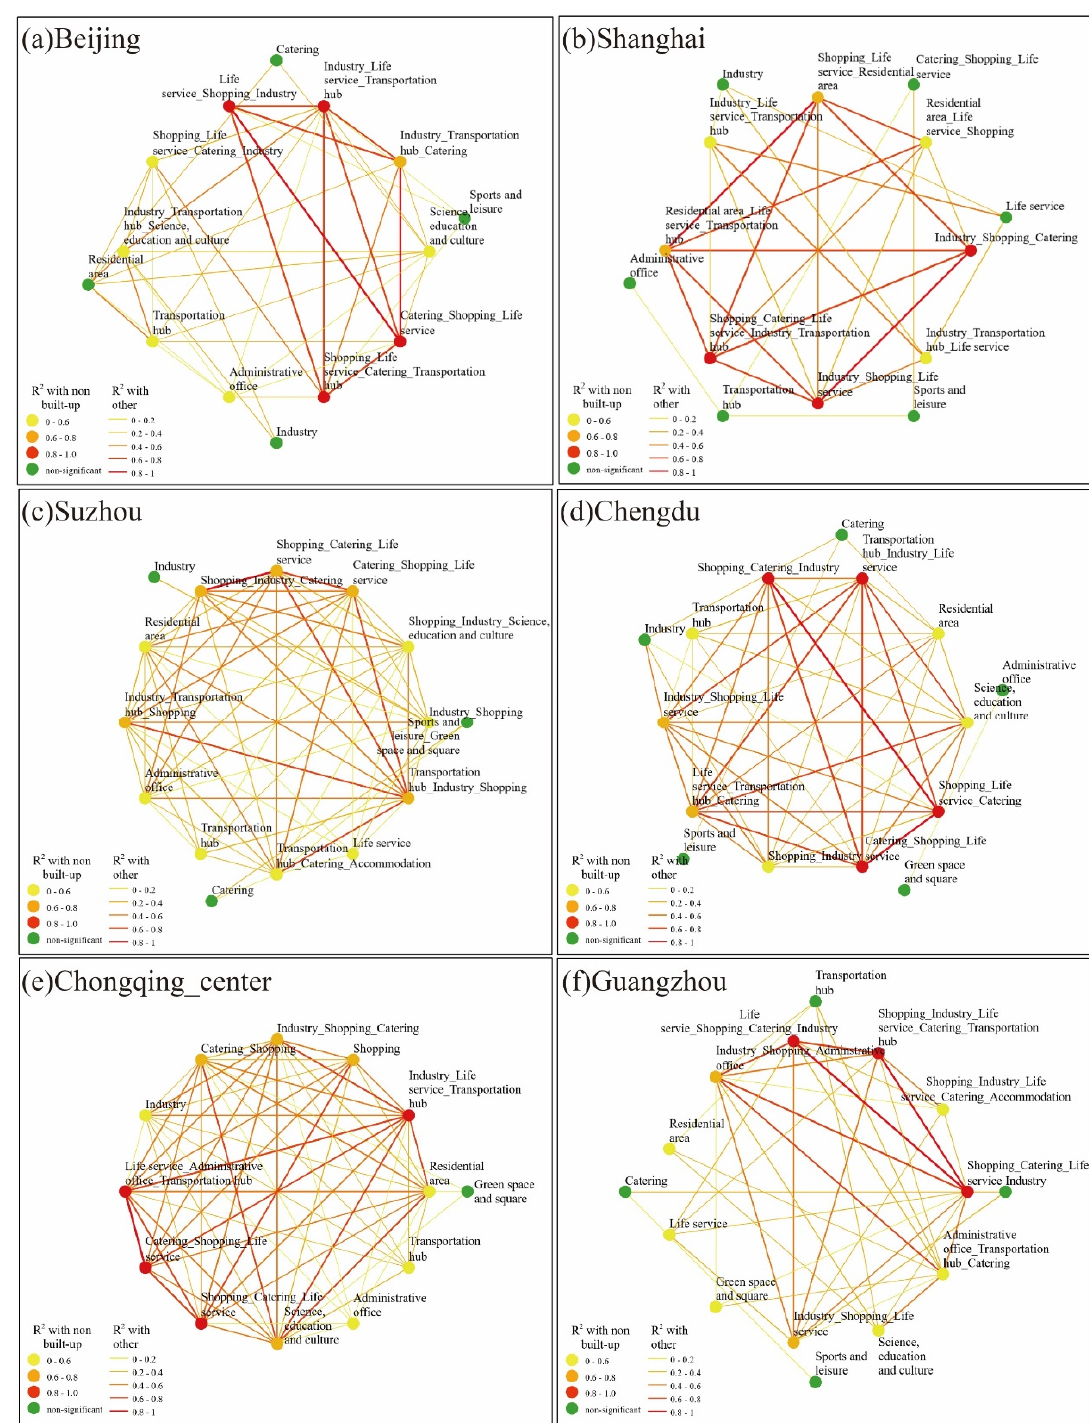
Figure 4. Functional correlation diagram for rank1 city. ( a ): Beijing—Tianjin—Hebei, ( b , c ): the Yangtze River Delta, ( d , e ): Chengdu—Chongqing, ( f ): the Pearl River Delta.